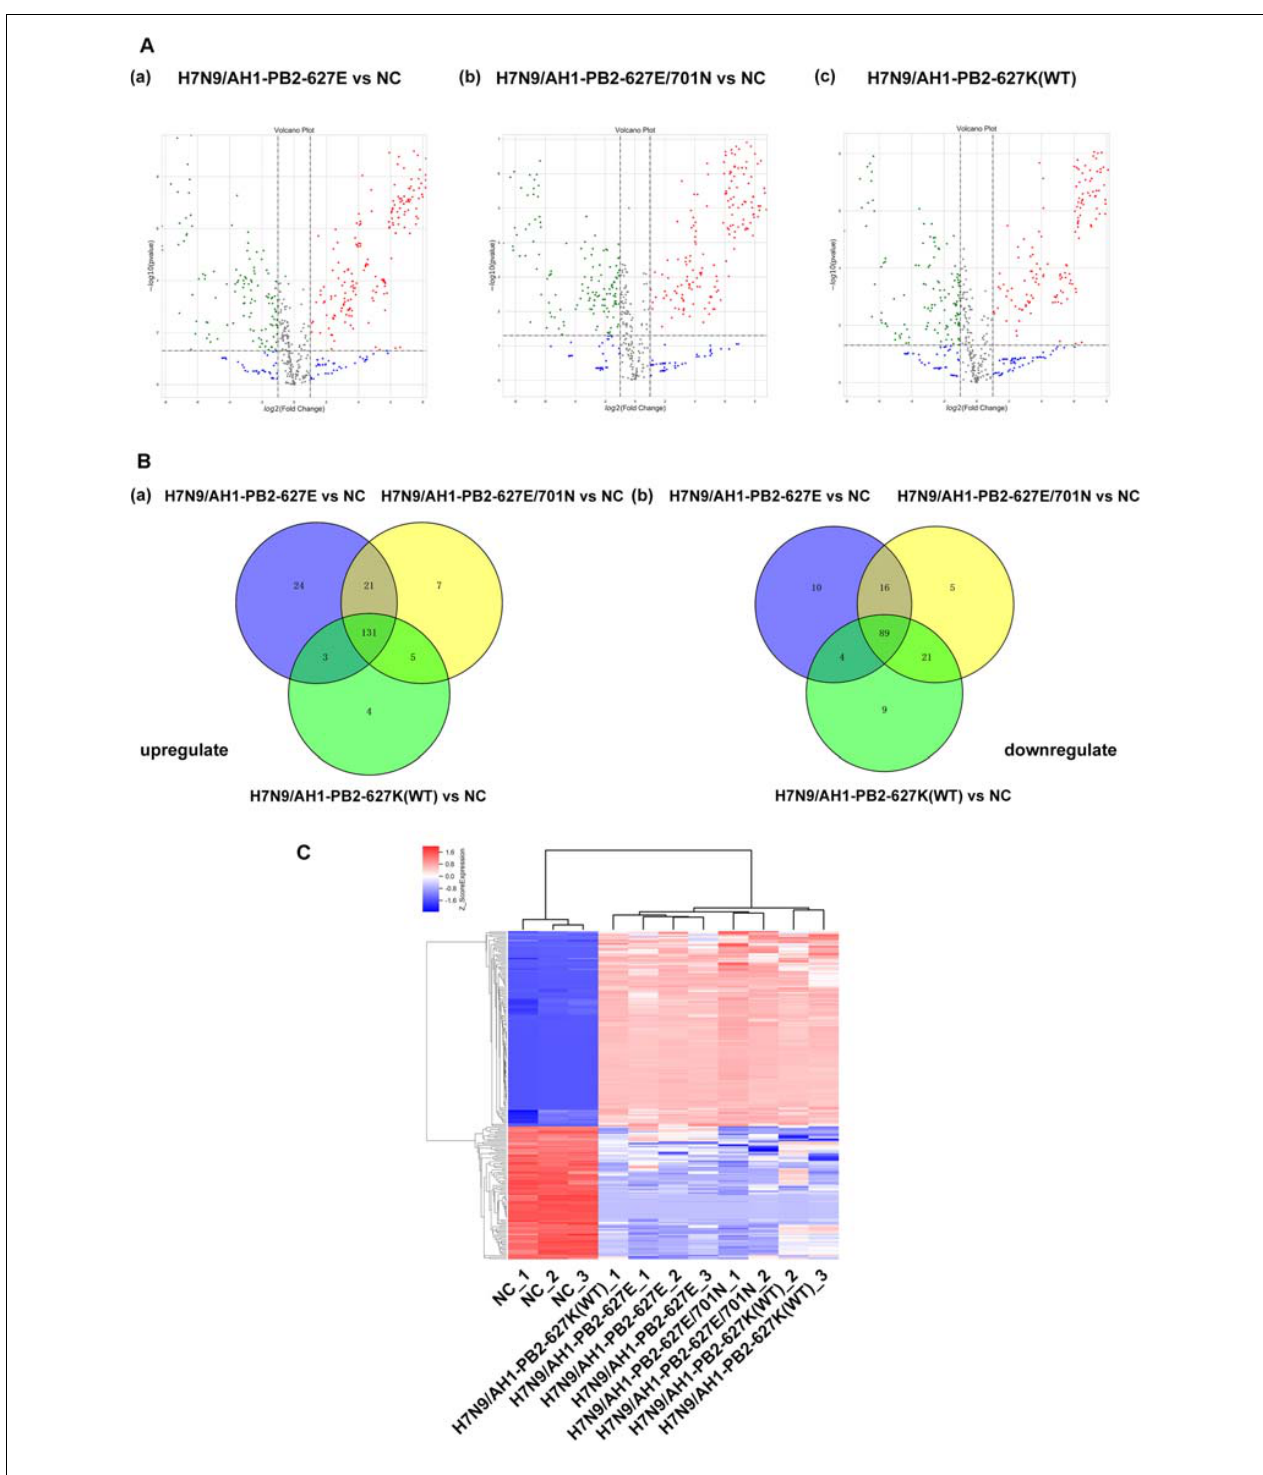
FIGURE 3 | Global analysis of microRNA expression profiles in mice lung infected with H7N9/AH1-PB2-627K(WT) and its mutant influenza viruses compared with negative control group (NC). (A) The scatter diagram shows the distribution of differential expression of miRNAs in different influenza virus infected groups relative to the NC group. Red and green dots denote up- and down-regulated differentially expressed miRNAs, respectively. (B) The Venn diagram shows the number of the common and specific differentially expressed miRNAs in the three influenza virus infected groups: H7N9/AH1-PB2-627E vs. NC (blue circle), H7N9/AH1-PB2-627E/701N vs. NC (yellow circle), and H7N9/AH1-PB2-627K(WT) vs. NC (green circle). (C) Hierarchical clustering presents the common differentially expressed miRNAs compared with NC group. Up-regulated miRNAs are shown in red and down-regulated miRNAs are shown in blue.